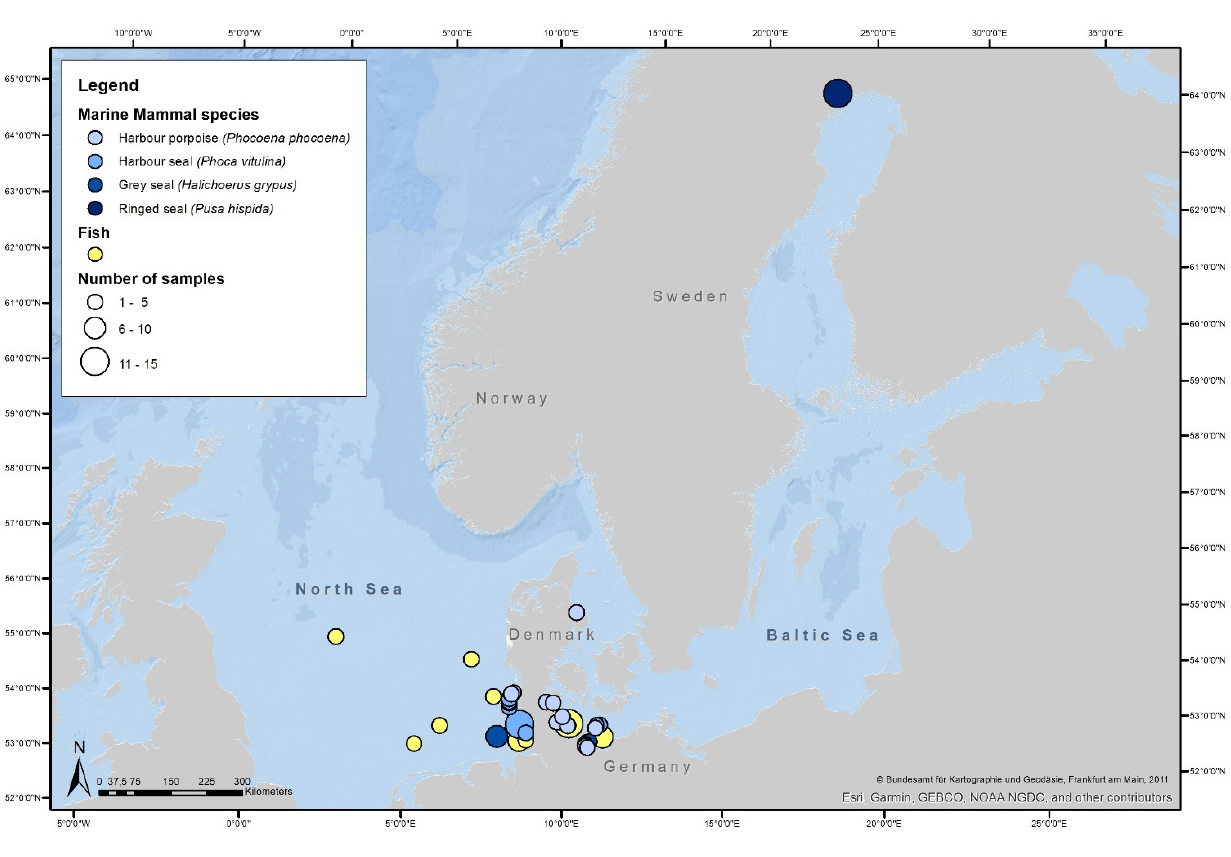
Figure 1. Sample map. The map indicates the sampling locations for the four marine mammal species and the fishes, as well as the sample size per location.